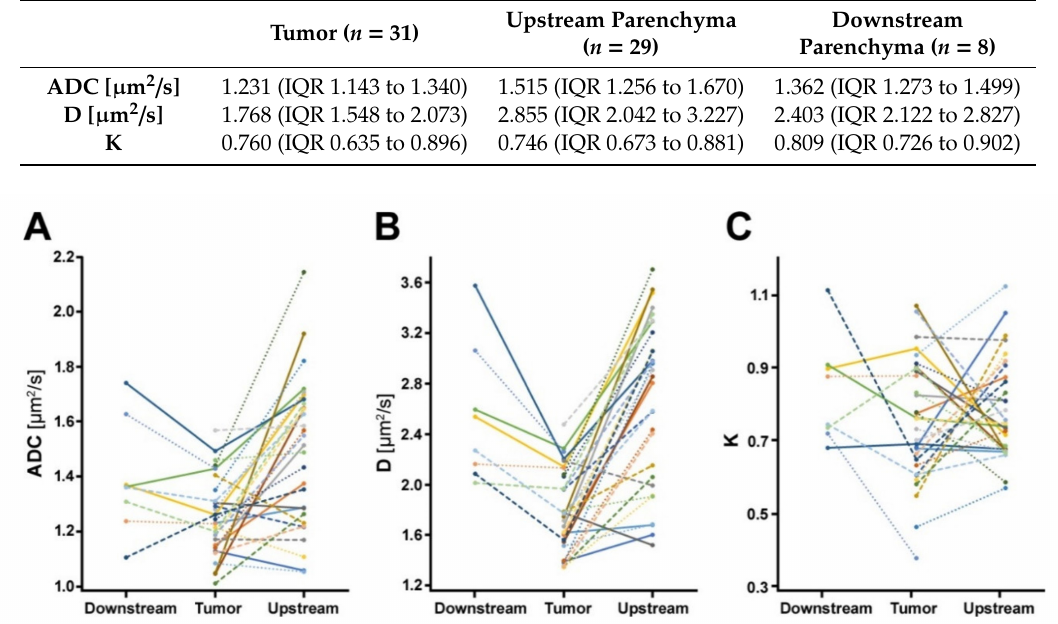
Figure 1. Line diagrams summarizing ( A ) ADC, ( B ) D, and ( C ) K values in PDAC patients. Each line represents one patient. Both ADC and D values were significantly lower in tumors than in upstream parenchyma. Di ff erences in water di ff usion between tumors and downstream parenchyma were only statistically significant for D, but not for ADC. K values did not di ff er significantly between tumors and non-neoplastic